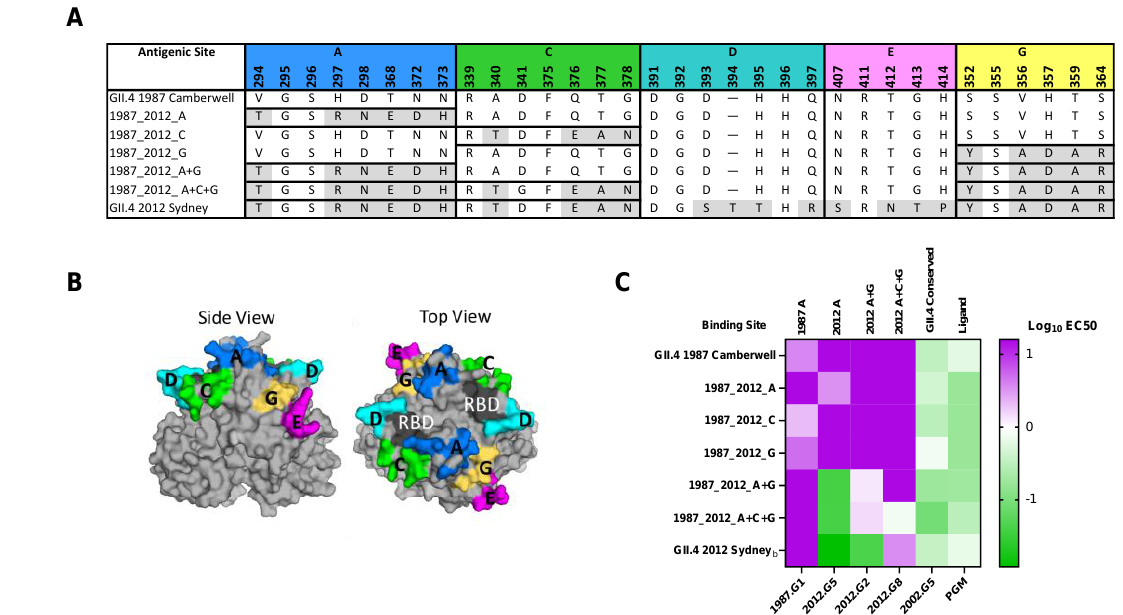
Figure 1. GII.4 2012 Sydney antigenic site chimera VLPs. ( A ) Residues of confirmed GII.4 hypervariable antigenic sites/epitopes in VLP studied here. Chimera VLPs are composed of GII.4 2012 Sydney antigenic sites in the backbone of GII.4 1987 Camberwell. ( B ) Antigenic sites in Panel A, color-coded on the structure of the GII.4 2012 Sydney dimer. Note: sites are colored as distinct entities, but antibodies may bind across sites. RBD: receptor binding domain. ( C ) VLPs characterized for epitope-specific nAb potency and ligand binding (Log EC50 µg/mL).